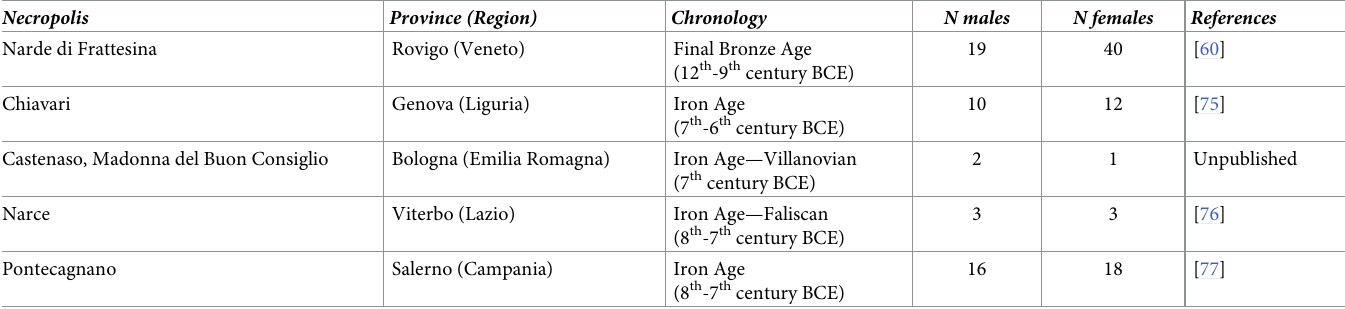
Table 1. Details of the archaeological sites and